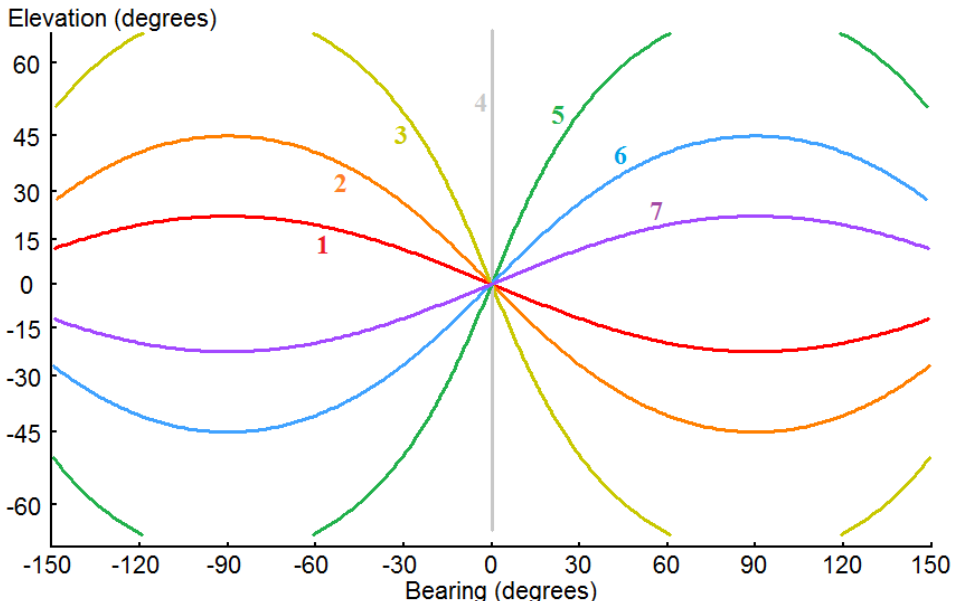
Figure 1. ( a ) Skeletonised synthetic-aperture image of the field of audition in a Mercator projection. Lambda circles are shown for seven discrete bearings, in which the head faces as it turns (or yaws) from 67.5° to the left (port) (index 1; coloured red), through 22.5° increments, to 67.5° to the right (starboard) (index 7; coloured violet) with respect to the mean position (0°, index 4; coloured grey). ( b ) The same lambda circles presented in ( a ), but shown in a top view.